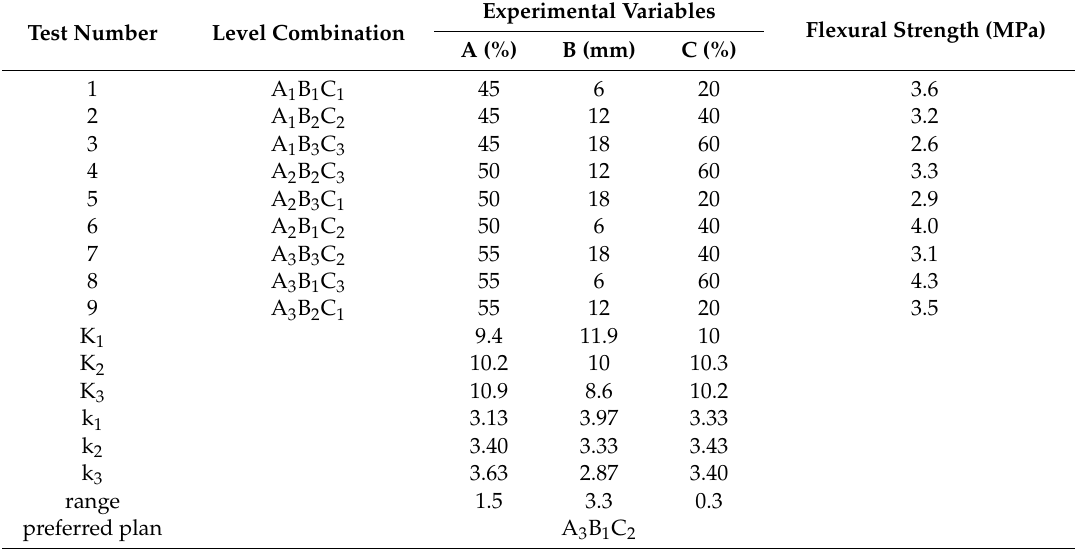
Table 4. Statistics pertaining to the measured flexural strengths.